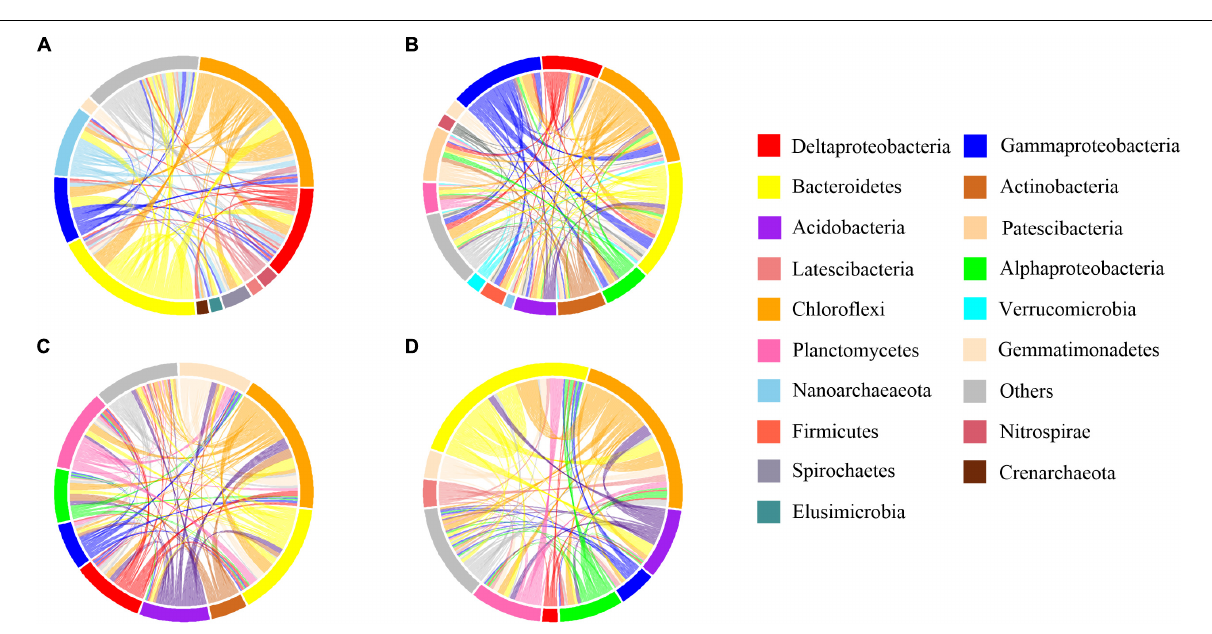
FIGURE 6 | Co-occurrence patterns of rare bacterial community. The profiles of co-occurrence links among dominant taxa. Connections are colored based on the most dominant taxon (relative abundance above 2%). (A) B sediment of the CON group (B) B sediment of the INV group (C) P sediment of the CON group (D) P sediment of the INV